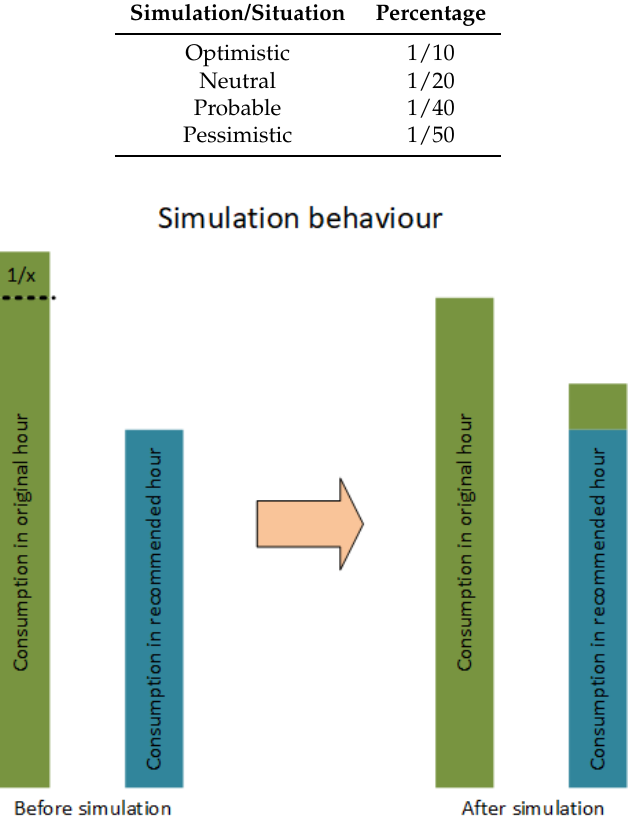
Figure 10. Simulation